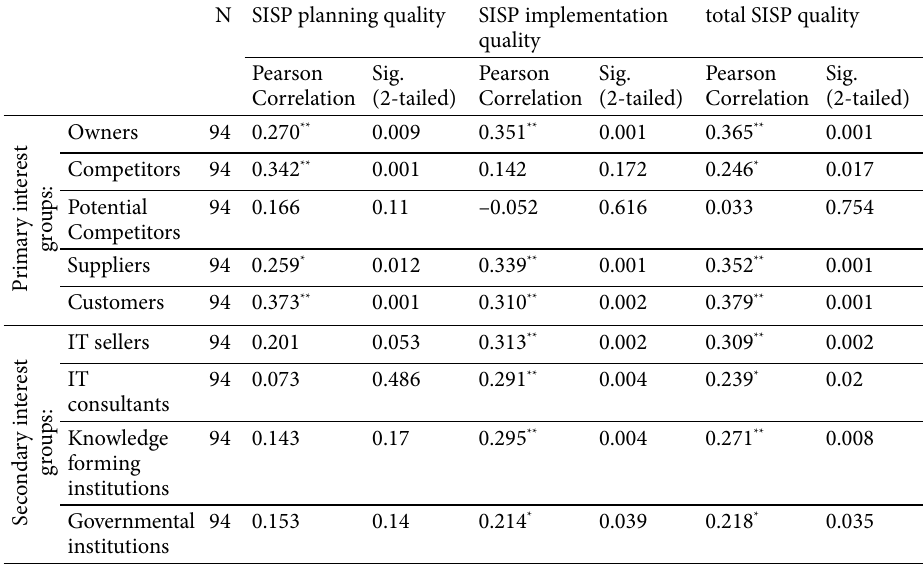
Table 3. Pearson’s correlation analysis between environmental factors and key SISP quality scores for SISP planning activities, SISP implementation activities and total SISP activities. N SISP planning